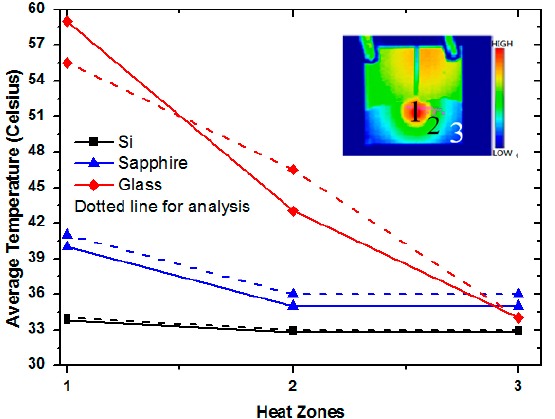
Figure 4. Peak wavelength variation vs. operation current for LEDs mounted on different submounts.